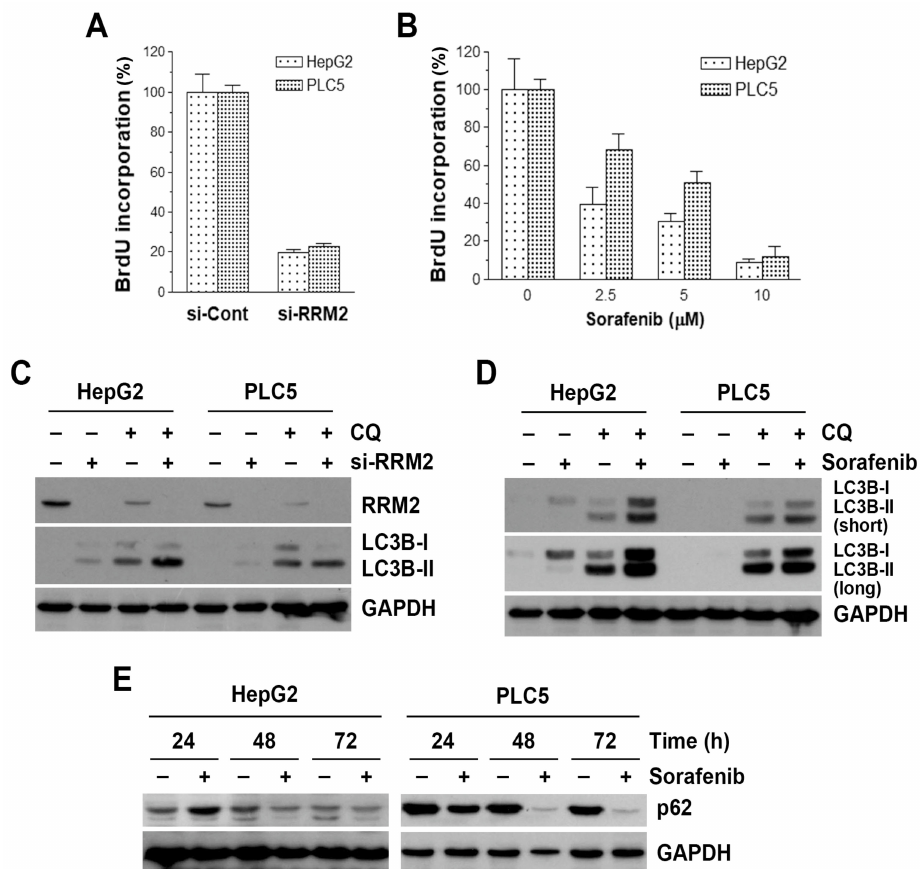
Figure 4. E ff ect of ribonucleotide reductase regulatory subunit M2 (RRM2) knockdown and sorafenib on cell proliferation and autophagy in hepatocellular carcinoma (HCC) cells. ( A ) HepG2 and PLC5 cells were transfected with RRM2 siRNA (si-RRM2) or the non-targeting control siRNA (si-Cont) for 72 h, and then BrdU cell proliferation assay was performed. ( B ) HepG2 and PLC5 cells were treated with 2.5, 5, and 10 µ M sorafenib for 48 h, and then BrdU cell proliferation assay was performed. ( C ) HepG2 and PLC5 cells were transfected with RRM2 siRNA (si-RRM2) or the non-targeting control siRNA for 48 h. Chloroquine (CQ), 30 µ M, was added to cell culture 6 h before cell harvest for Western blot analysis. ( D ) HepG2 and PLC5 cells were treated with 5 µ M sorafenib for 48 h. CQ, 30 µ M, was added to cell culture 6 h before cell harvest for Western blot analysis. ( E ) HepG2 and PLC5 cells were treated with 5 µ M sorafenib for 24, 48, and 72 h, and then cells were harvest for Western blot